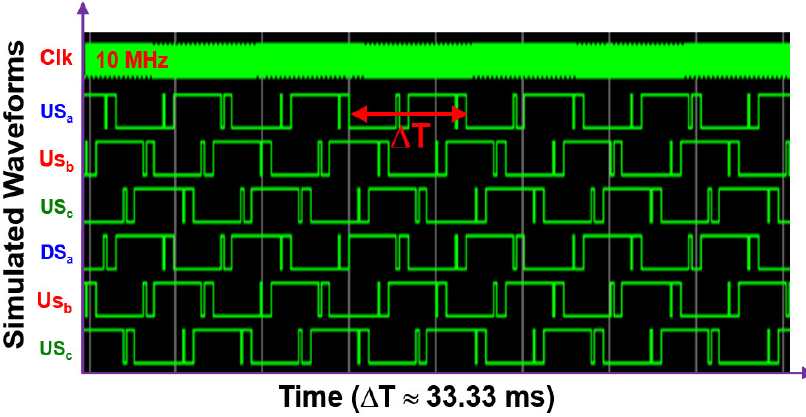
Figure 17. Simulated voltage waveforms of six-arm signals in the inverter at a clock frequency of 10 MHz and a basic frequency of 1800 rpm (≈33.33 ms).